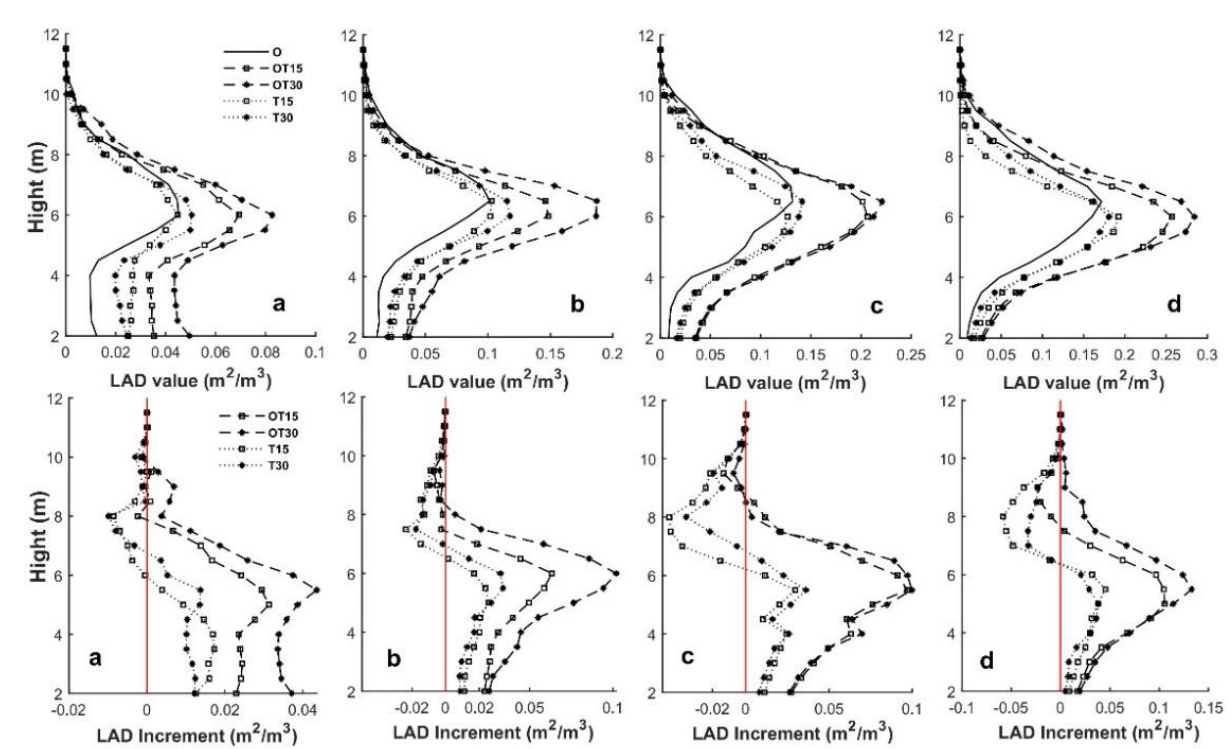
Figure 10. In areas with different LAI levels, the leaf area density (LAD) distribution and the LAD increment relative to O of five schemes at different heights from ground (sub-voxel size is 0.09 m). a is the area with LAI interval 0.5–1, b is the area with LAI interval 1–1.5, c is the area with LAI interval 1.5–2, d is the area with LAI interval 2–2.5.